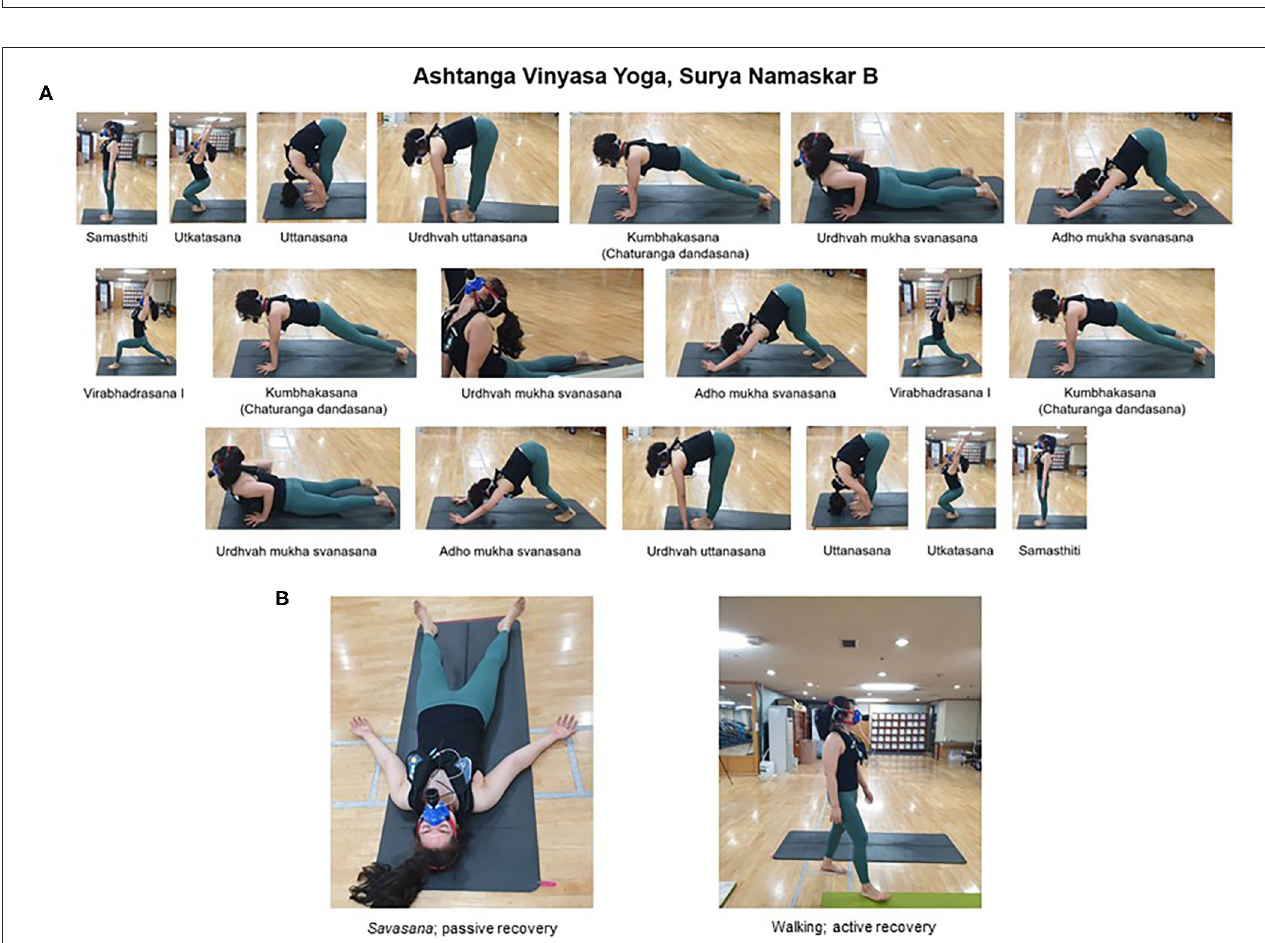
FIGURE 1 | Study procedure. All subjects conducted high-intensity hatha yoga ( n ( savasana ; n 10) recovery groups. =